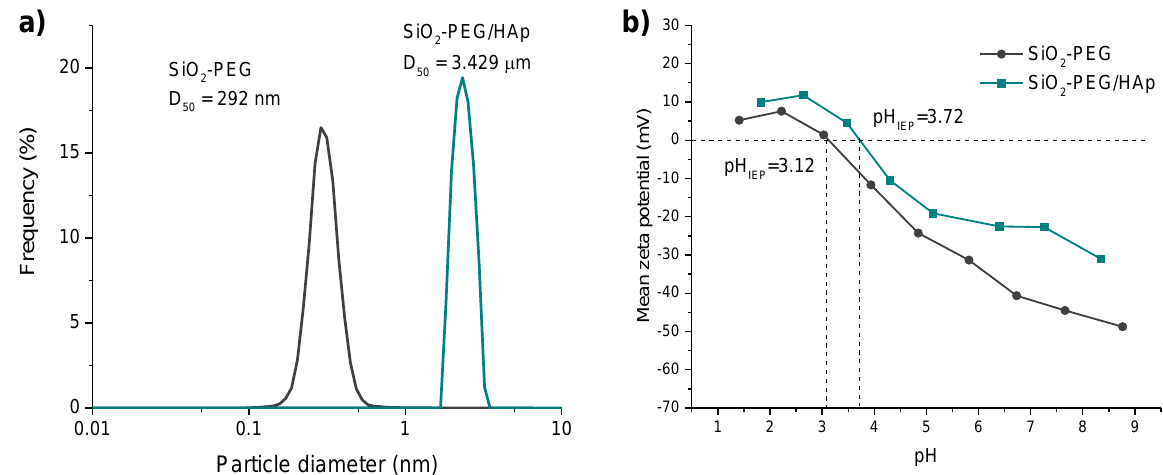
Figure 7. Dynamic light scattering (DLS) spectra ( a ) and zeta potential ( b ) of SiO 2 -PEG and SiO 2 -PEG/HAp samples. Based on all results obtained from chemical, structural, and morphological characteri- zation of the SiO 2 -PEG/HAp sample, the biomimetic nucleation and growth of carbonated hydroxyapatite crystals on the surface of SiO 2 microspheres (SiO 2 -PEG sample) is illus- trated in Figure 8.